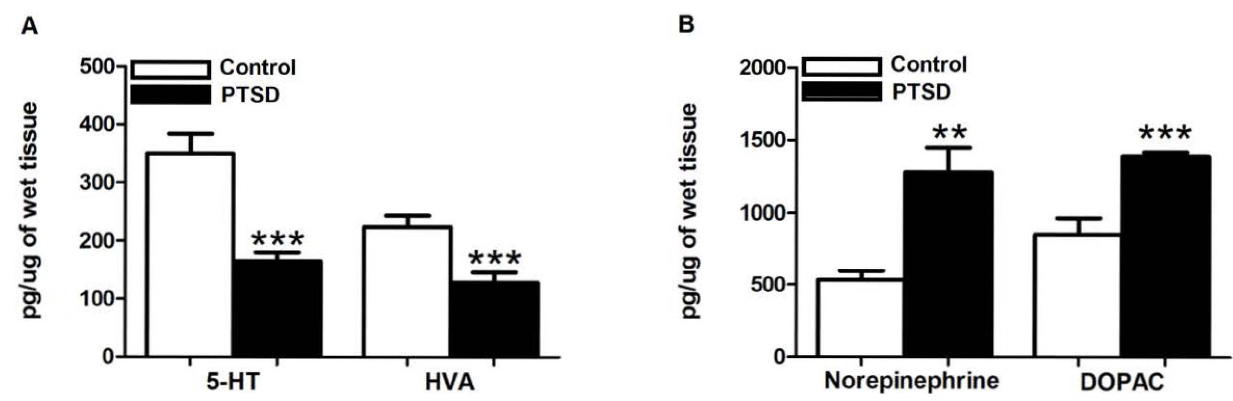
Figure 1. Hippocampus 5-HT, HVA, NE, and DOPAC levels post-stress. 5-HT and HVA were both significantly down-regulated (A), while NE and DOPAC were both significantly elevated (B), in the hippocampus in response to the predator exposure/psychosocial stress model. All data are presented as mean 6 SEM. **p , 0.001, ***p , 0.0001 relative to the control group.